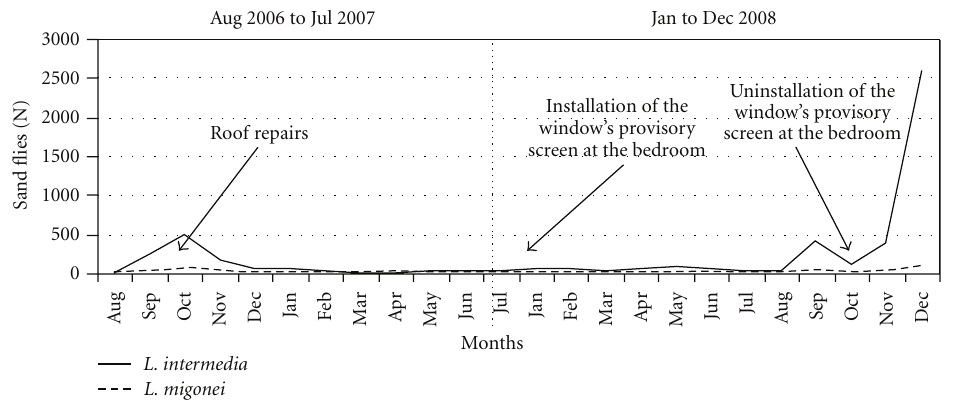
Figure 4: Environmental modifications and monthly capture of L. (N.) intermedia and L. migonei in the domicile of house 3, August 2006 to July 2007 and January to December 2008.